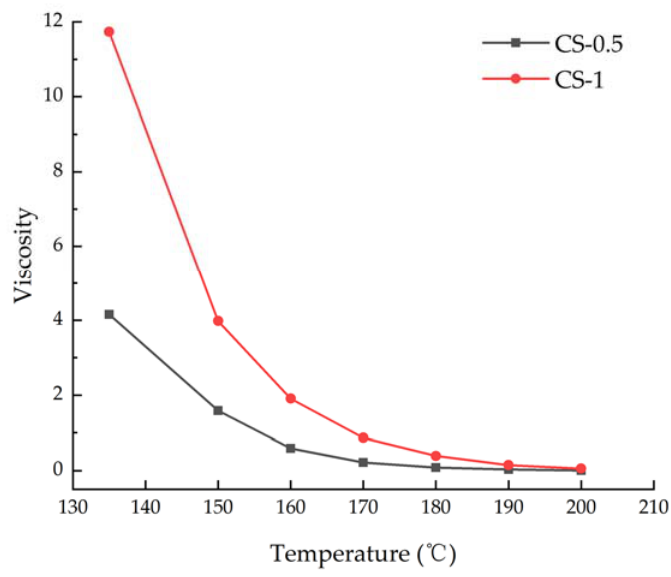
Figure 6. Viscosity–temperature curve diagram of grouting materials.